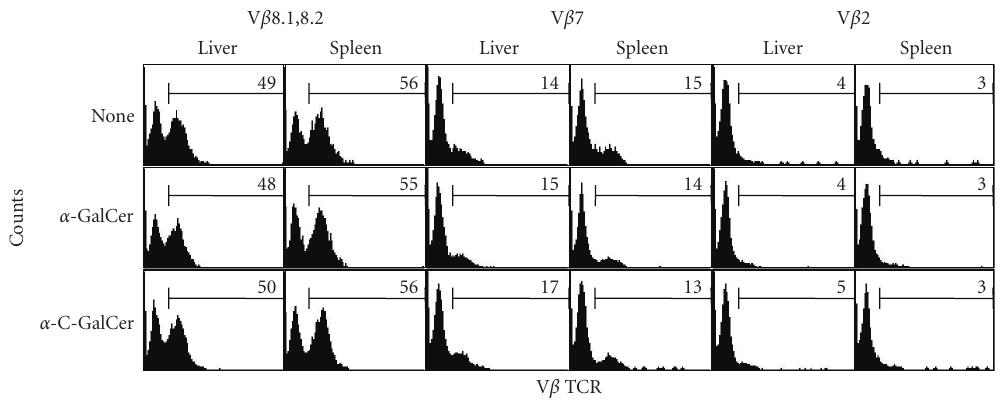
Figure 6: TCR β usage does not a ff ect in vivo V α 14i NKT cell activation stimulated by α -GalCer or α -C-GalCer. Groups of 2 WT C57BL/6 were injected i.p. with 1 μ g of α -GalCer or α -C-GalCer, or with nothing, and 72 hours later splenocytes and hepatic lymphocytes were isolated and stained for V α 14i NKT cells using α -GalCer-loaded mouse CD1d-IgG 1 dimers, as well as for V β 8.1/8.2, V β 7, and V β 2. V α 14i NKT cells were gated, and FACS analyzed for the three di ff erent V β gene segments. The numbers shown represent the percentage of cells expressing the indicated V β segment. The data shown comes from one of two independent experiments with similar